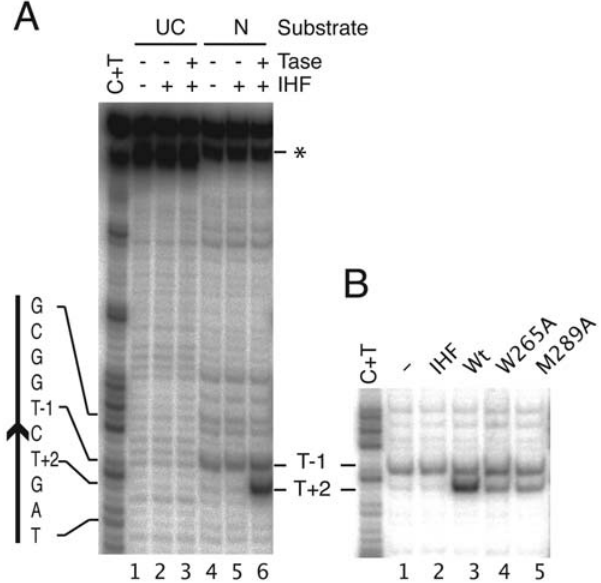
Figure 2. Base flipping after the first nick. Transpososomes were assembled and treated with KMnO 4 . KMnO 4 oxidizes thymine bases in distorted DNA, particularly if they are in an extra-helical position [23]. Oxidation converts the thymine to cis-thymine glycol which, upon piperidine treatment, undergoes further degradation leading to cleavage of the DNA strand. After quenching the DNA was analyzed on a DNA sequencing gel. A The substrate was either uncleaved or pre- nicked. The nucleotide sequence of the transposon end is given on the left, with the arrowhead indicating the location of the transposon end. UC, uncleaved substrate; N, pre-nicked substrate, T’ase, transposase; IHF, integration host factor; *, This band is an artifact that appears to be caused by a heterogeneity at the 5 9 -end of the DNA strand. Since the label is located at the 3 9 -end of the DNA strand, this artifact does not contribute to the sequencing ladder or the permanganate footprints. B As in part A except that the transpososomes were assembled on the pre-nicked substrate with the wild type and mutant proteins.